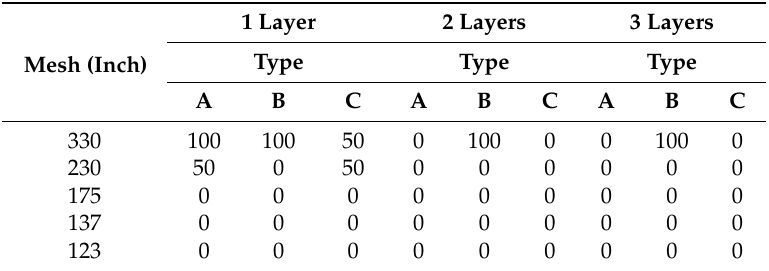
Table 1. Failures rate (%) for TLD when 1–3 layers of dielectric ink are used.